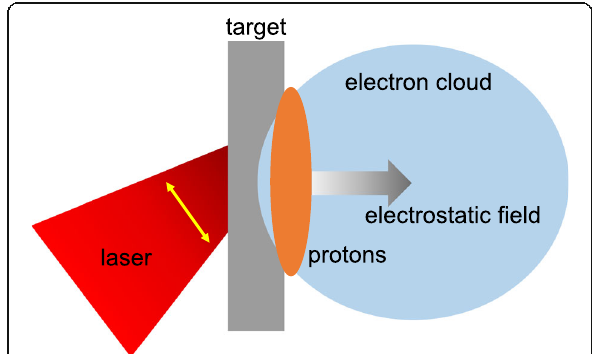
Fig. 17 Schematic illustration of the target normal sheath acceleration mechanism. A solid density target with a thickness of a few microns is irradiated with a P-polarized laser